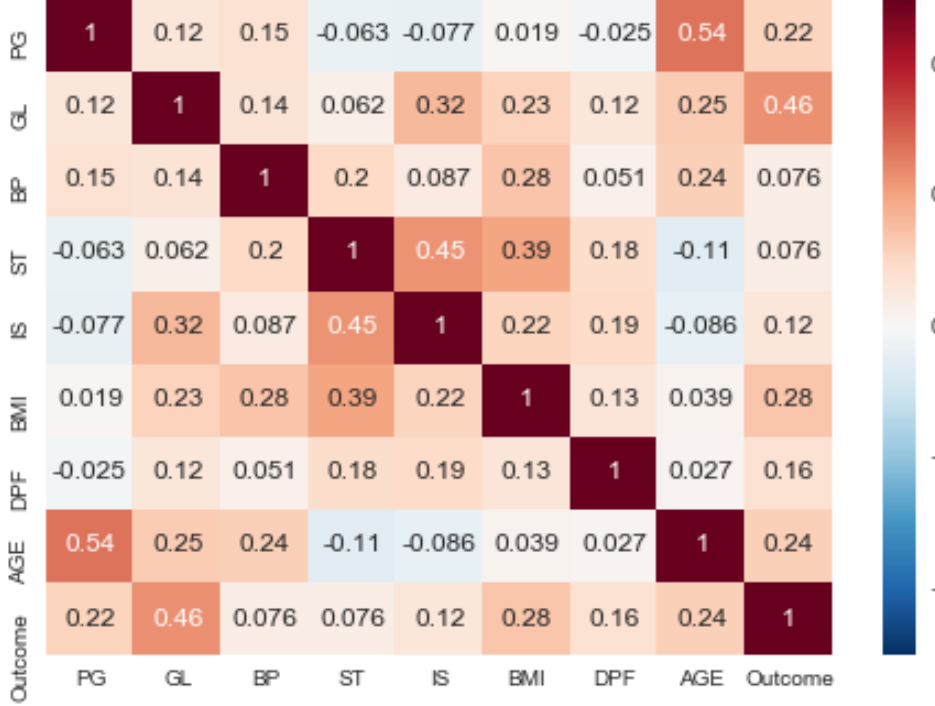
Figure 4. Heat map of the